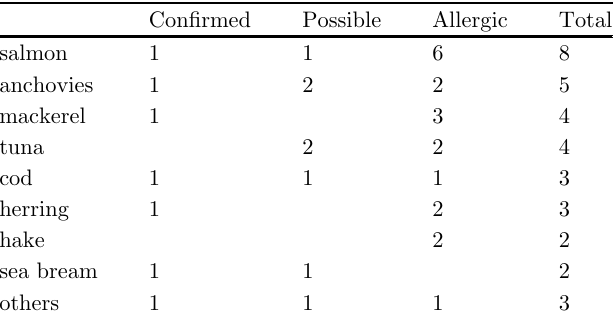
Table 2. Fish incriminated in the occurrence of cases of anisakidosis identi fi ed in France, 2010 – 2014. For some cases, the species was unknown. For one case several species were